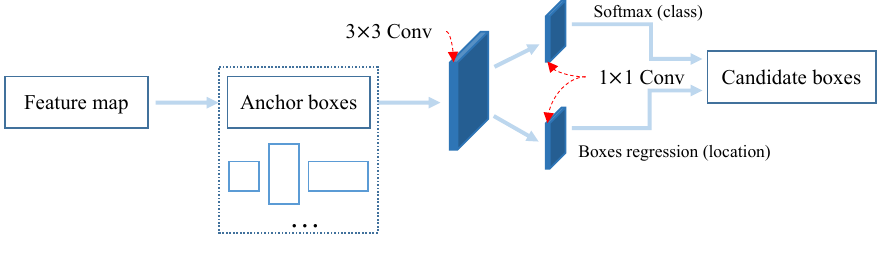
Figure 8. The structure of